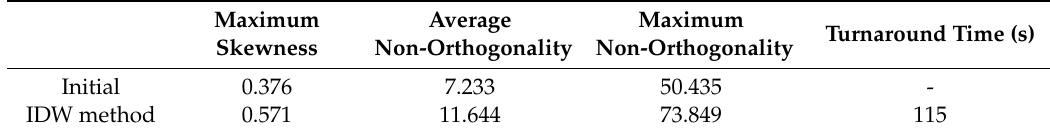
Table 2. Quality of deformed mesh using the IDW method.